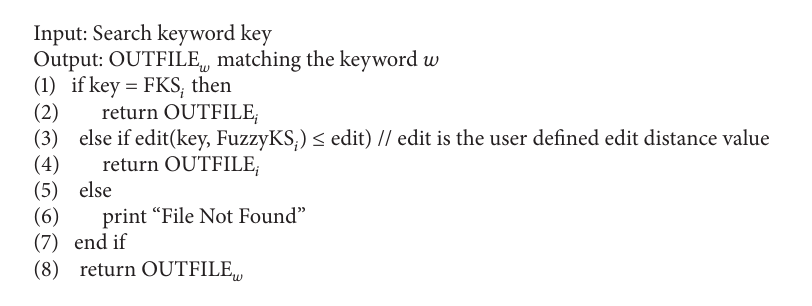
Algorithm 2: Fuzzy(key, FuzzyKS ed = 1